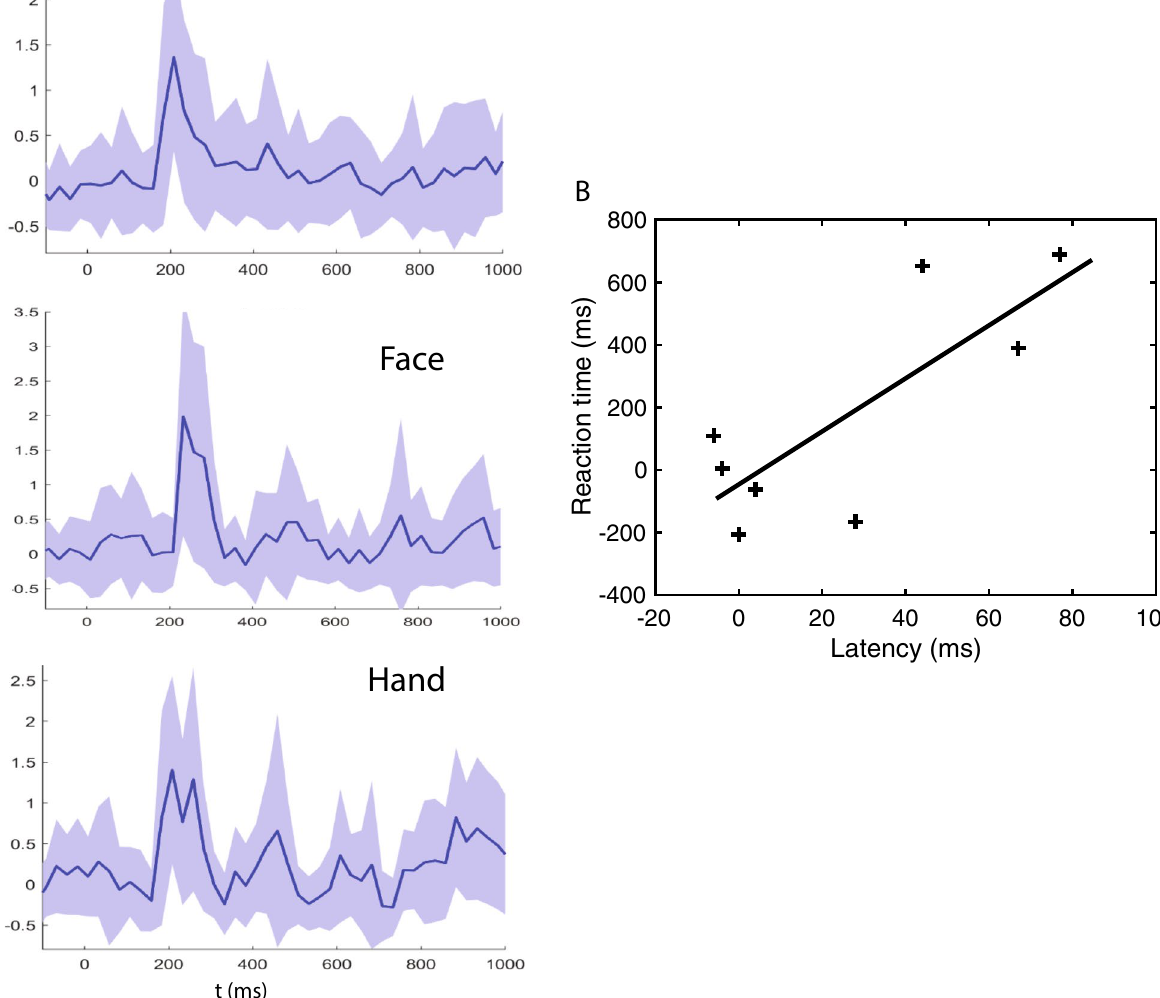
Figure 2. Masking effects. ( A ) responses of TP leads (VL and T averaged) to static onset in gender task of patient P1 without mask (no), face masked (face) or hand masked (hand); ( B ) Increase in RT with masking as a function of increase in median latency of TP responses across 4 patients (P1, 2, 3, 7); DeltaRT: 46 ms + 8.5 DeltaLat, correlation: r = 0.79, p < 0.02. The latency was determined as the time the z-scored response crossed a threshold of 3SD relative to